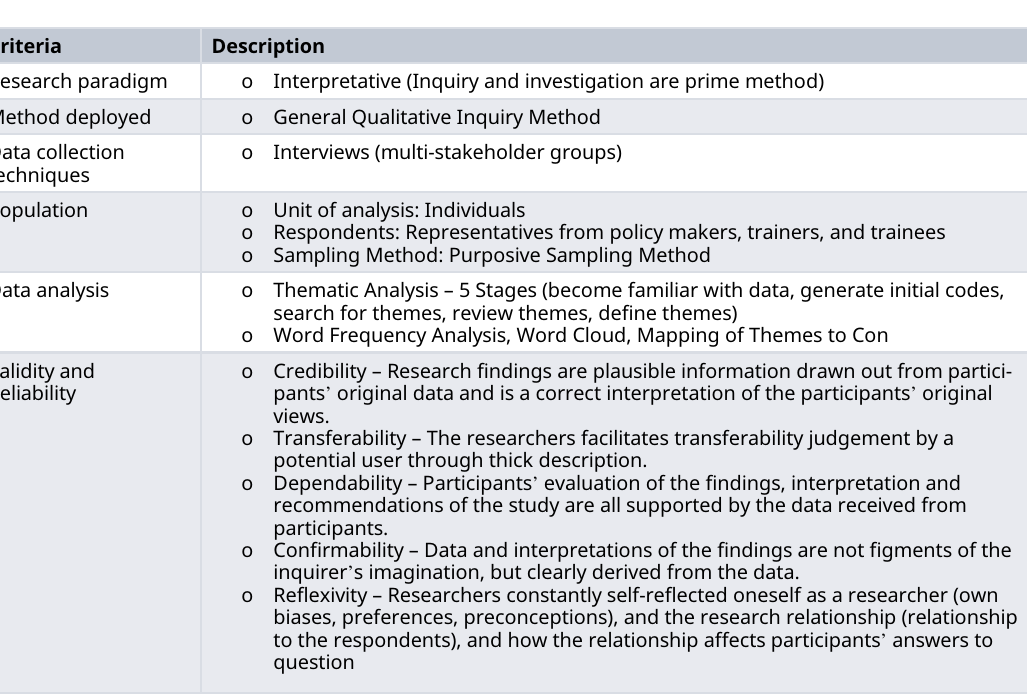
Table 1. Qualitative research design used for the